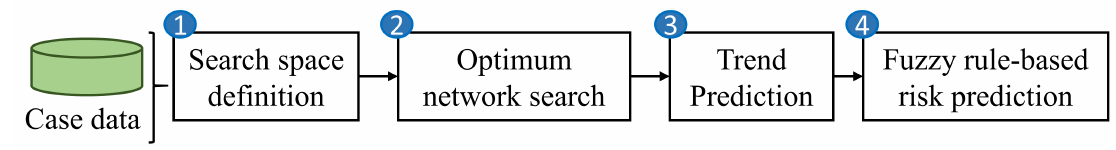
Figure 2. Modules of the proposed